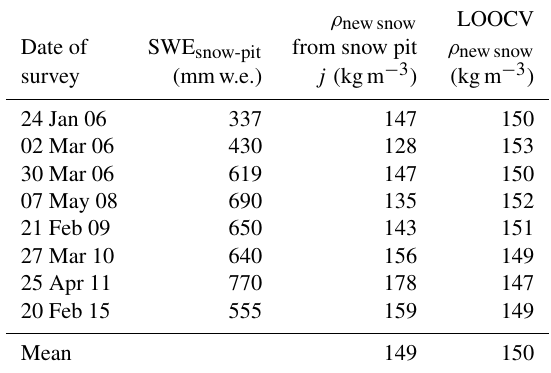
Table 2. The leave-one-out cross-validation (LOOCV). For each survey, we reported the SWE values measured by means of the snow pit (SWE snow-pit ) , the values of the new snow density applying the Eq. (3) ( ρ newsnow from snow pit j ), and the new snow density ob- tained applying the LOOCV method (LOOCV ρ newsnow ) . ρ newsnow